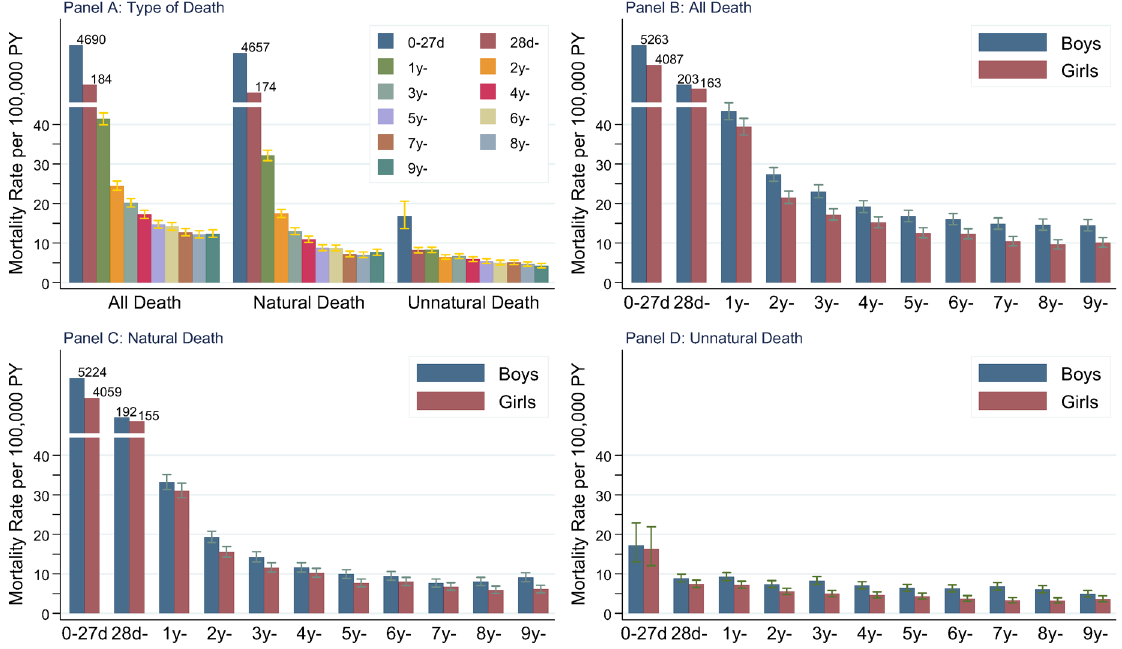
Fig 1. Mortality rates in children aged 0 – 9 years over type of death and age (28d: 28 – 364